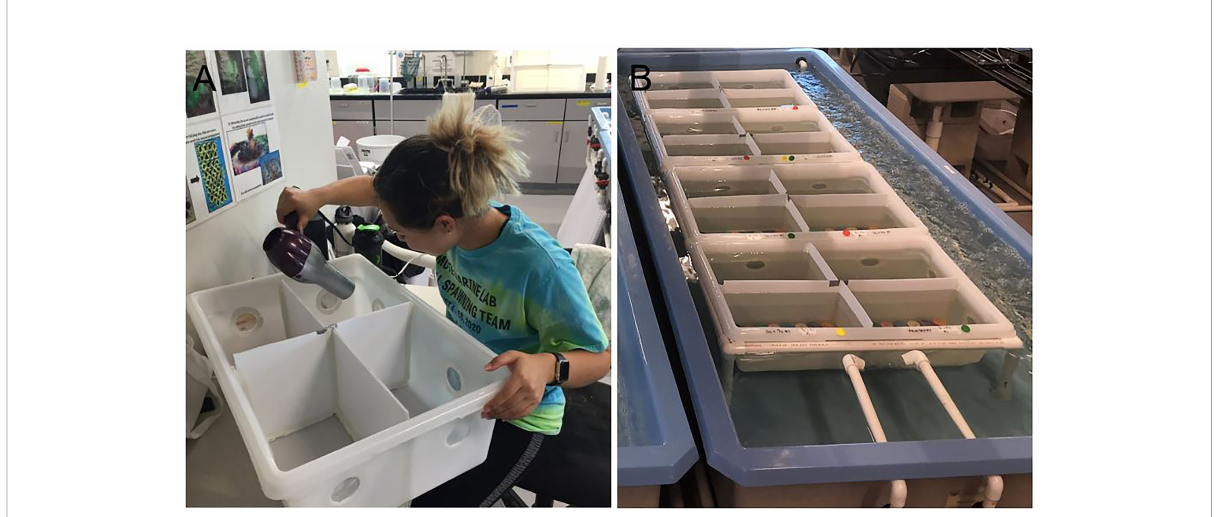
FIGURE 3 Flow-through settlement containers. (A) To allow seawater to fl ow through the container, multiple holes are cut out and covered with mesh. To allow for replicate settlement assays, containers were divided into quadrants. (B) Settlement bins are stabilized using a PVC frame and held in a raceway with a continuous fl ow of fresh seawater. Source: Hanna Koch.